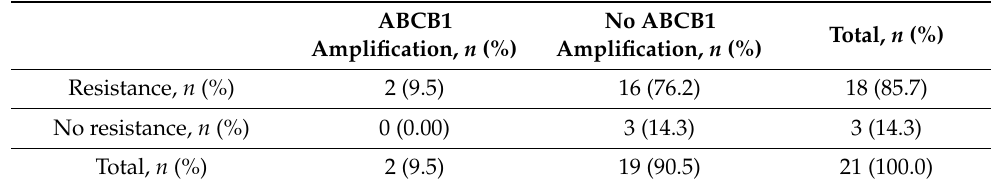
Table 3. Association between ABCB1 amplification and primary resistance to cabazitaxel in cohort B ( n = 21).